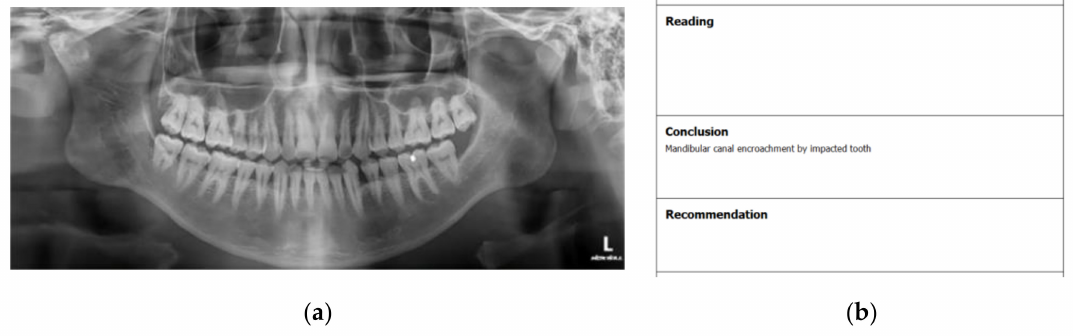
Figure 1. ( a ) Sample DPR image and ( b ) study report.